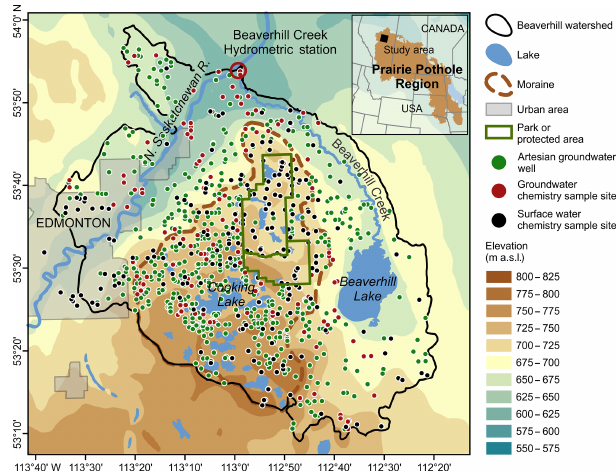
Figure 1. Beaverhill watershed, Alberta, Canada. The locations of 1413 artesian groundwater wells installed in the bedrock and screened 30 to 80m below the land surface are shown (green dots). Black dots depict the locations of 208 lakes, wetlands and ponds wherein chemistry and isotopic measurements were taken. Red dots depict the locations of 121 shallow (<10m deep) groundwater wells wherein groundwater chemistry measurements were taken. The red ring shows the location of Beaverhill Creek monitoring station. The inset shows the map of the Prairie Pothole Region of North Amer-